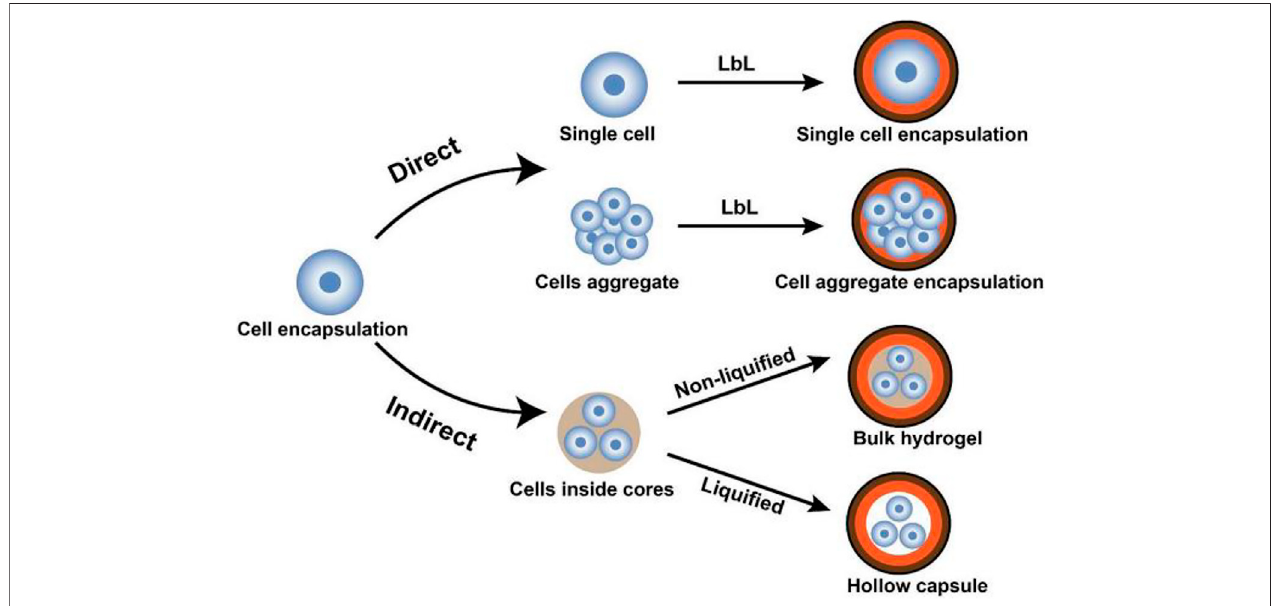
FIGURE 4 | Schematic representation of LBL encapsulation of cells. In the direct approach, cells (single or aggregate) are coated by encapsulating materials, whereas, in the indirect approach, cells are initially encapsulated in core materials then covered by LBL self-assembled shells (Liu et al.,